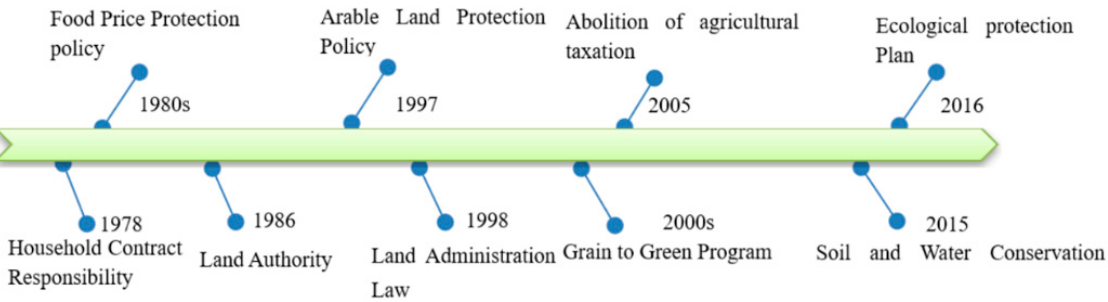
Figure 7. Chronology of the implemented agricultural policies since 1978. Apart from agricultural policies, the ever-increasing population also acted as an un- derlying factor that stimulated land use conversions [33]. During past decades, population in the three provinces (i.e., Heilongjiang, Jilin, and Liaoning Provinces) grew progressively from 1960 to 2015. For example, in Heilongjang Province, the population has increased from 18.07 million in 1960 to 37.92 million in 2010 (Figure 8).The increased population led to the establishment of more settlements and clearing of more vegetative cover for food production